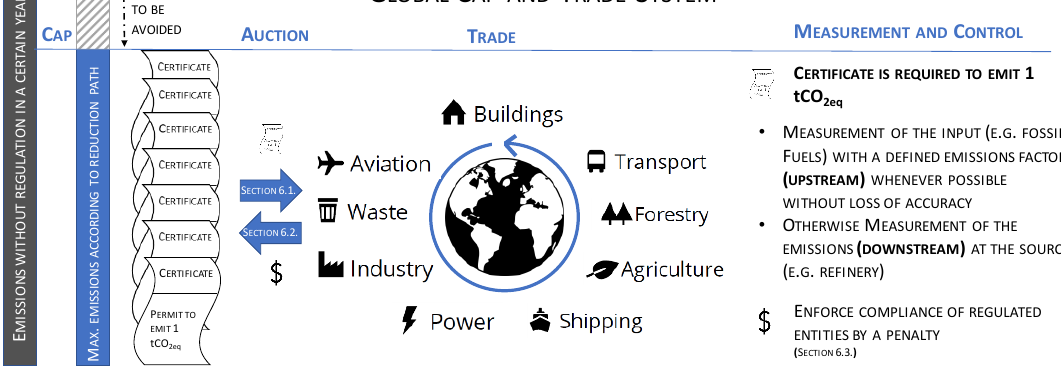
Figure 5. Proposal of a hybrid cap-and-trade system.